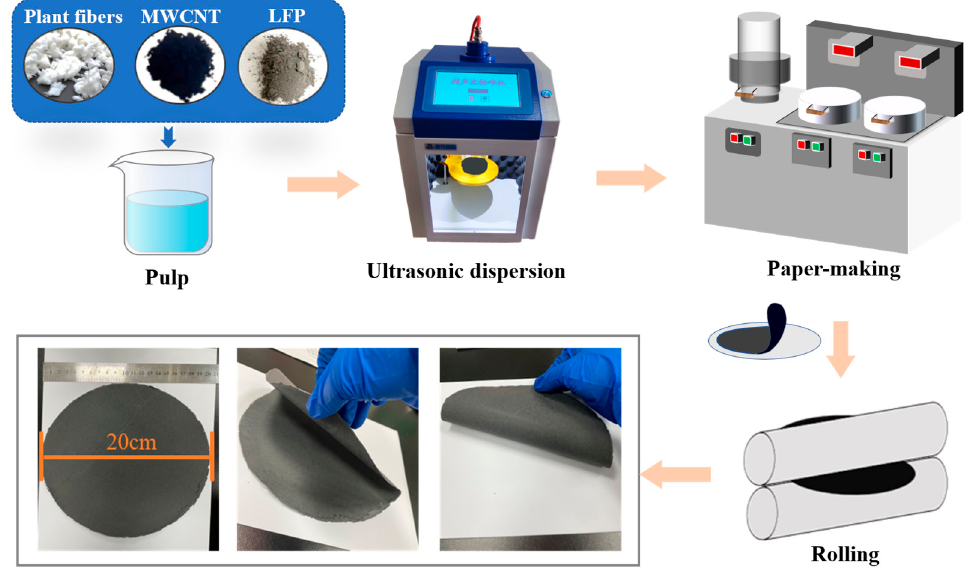
Figure 2. LFP paper electrodes preparation process.